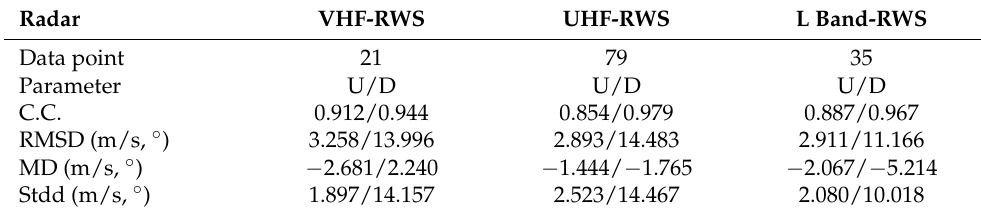
Table 5. Comparisons of horizontal wind velocity (U) and wind direction (D) between wind profilers and rawinsonde